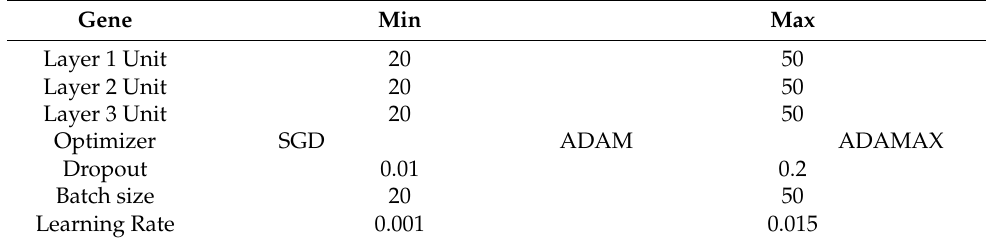
Table 2. LSTM gene: hyper-parameters.